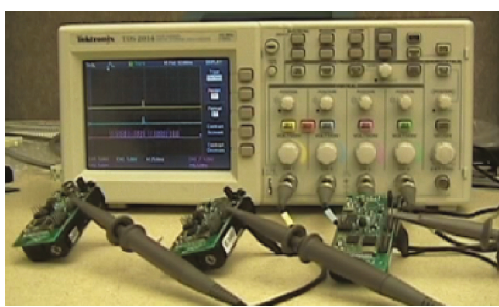
Figure 21: Experimental setup with 3 FireFly